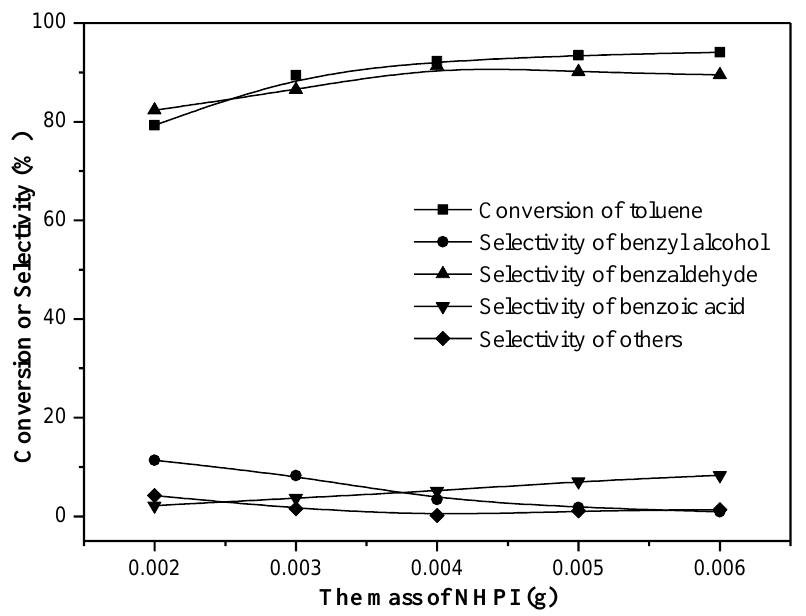
Figure 9. Effect of the mass amount of NHPI. Reaction conditions 0.20 g Co-ZIF, 0.500 mmol toluene, 20 mL HFIP, 0.12 MPa O 2 , 313 K and 240 min.